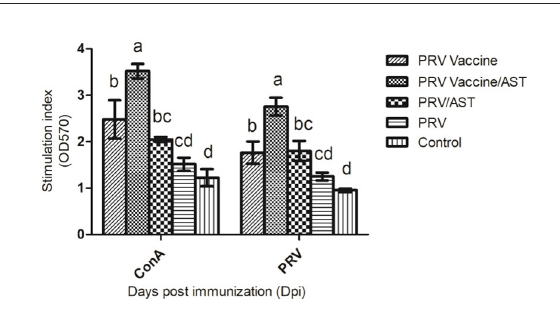
FIGURE2 Lymphocyte proliferative response. At 28 dpi, mice from each group ( n = 5) with different treatments were euthanized, and splenocytes were stimulated with Con A and inactivated PRV antigen for 48h for analysis of lymphocyte proliferation using the CCK8 method; the results are shown as a stimulation index (SI). Data are expressed as the mean ± SD ( n = 5). Bars with different letters indicate significant differences ( p <